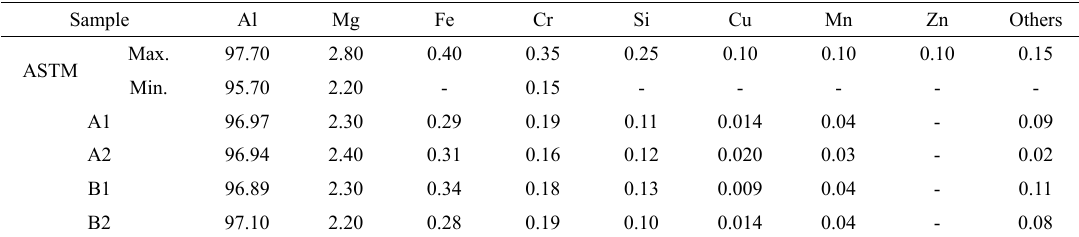
Table 3. Chemical composition of studied plates